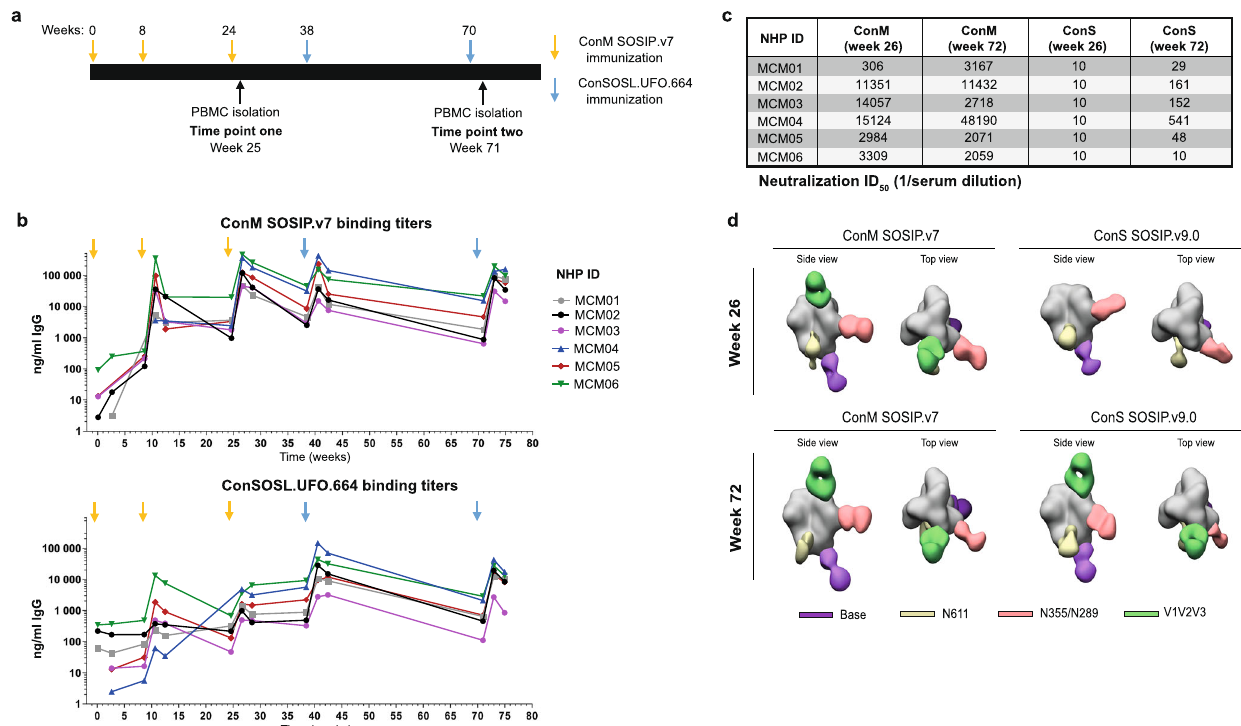
Fig. 1 ConM SOSIP.v7 and ConSOSL.UFO.664 immunogens induce strong serological responses in NHPs. a Immunization and PBMC isolation schedule. b ConM SOSIP.v7-speci fi c and ConSOSL.UFO.664-speci fi c serum IgG binding titers (ng/ml) developed following ConM SOSIP.v7 (yellow arrows) and ConSOSL.UFO.664 protein immunizations (blue arrows). c ConM and ConS serum neutralization titers at week 26 and week 72 for six immunized NHPs. Neutralization ID 50 is shown for each animal (1/serum dilution). d Antibody speci fi cities were determined by EM-based polyclonal epitope mapping (EMPEM). Puri fi ed Fabs from week 26 and week 72 sera were complexed with either ConM SOSIP.v9.0 or ConS SOSIP.v9.0 trimers. Composite fi gures of the various antibody speci fi cities detected by the 3D analysis are shown for all NHPs combined. Antibodies were detected targeting the V1V2V3 interface, the N611-glycan region, the N355/N289-glycan epitopes, and the base of the